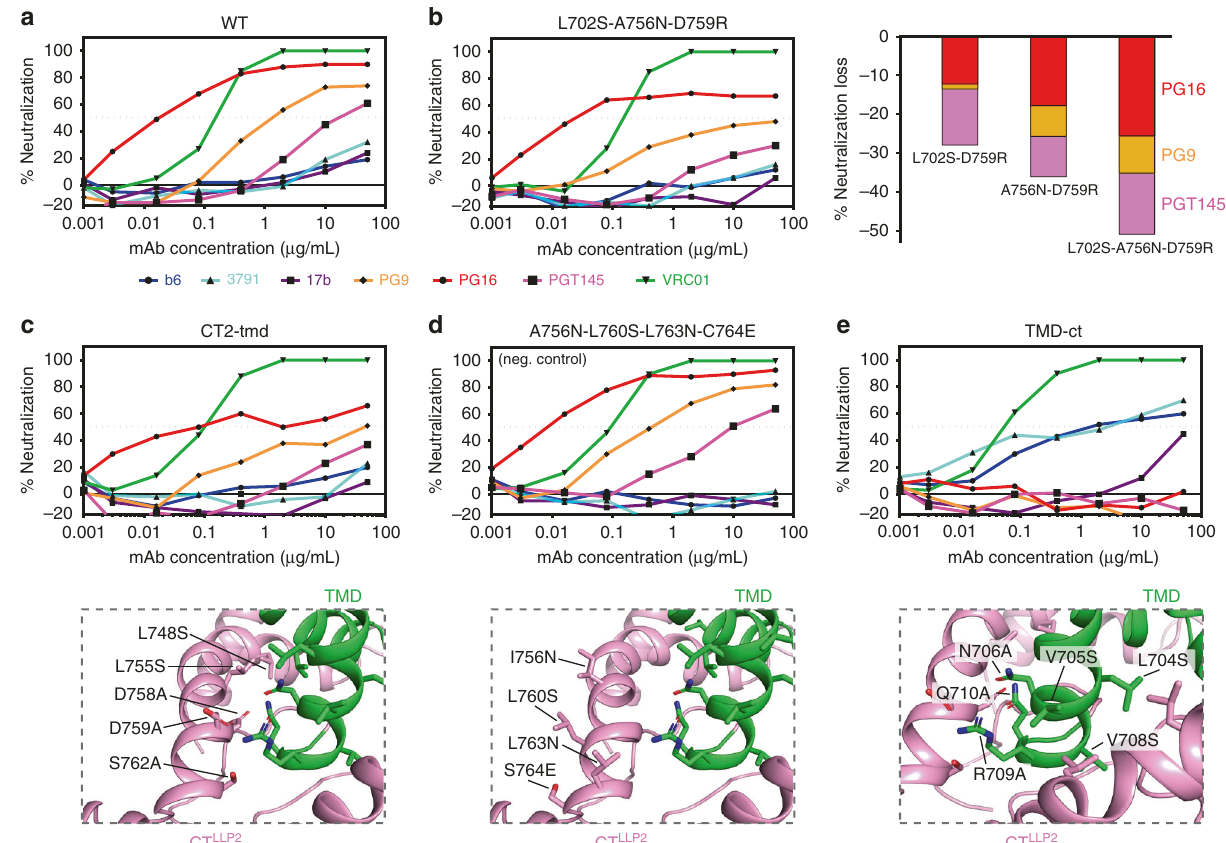
Fig. 4 Effect of mutations in the CT on Env antibody sensitivity. a Antibody neutralization of pseudovirus containing the 92UG037.8 Env determined for non-neutralizing antibodies, including b6 (CD4 binding site; blue), 3791 (V3; cyan), and 17b (CD4-induced; purple), and trimer-speci fi c bnAbs, including PG9 (orange), PG16 (red), and PGT145 (magenta). The CD4 binding site bnAb VRC01, used as a control antibody, is shown in green. b Antibody neutralization of pseudovirus containing the L702S-A756N-D759R mutant. Right panel shows the relative decrease of sensitivity to the trimer-speci fi c bnAbs of double and triple mutants bearing the D759R. c Antibody neutralization of pseudovirus (upper panel) containing a larger number of mutations in the CT (lower panel). d Same as ( c ) but for the mutant with mutations on the opposite side of the CT – TMD interface. e Same as ( c ) but for the mutant containing TMD mutations that break the hydrophobic and hydrophilic TMD – CT interactions. Source data are provided as a Source Data fi